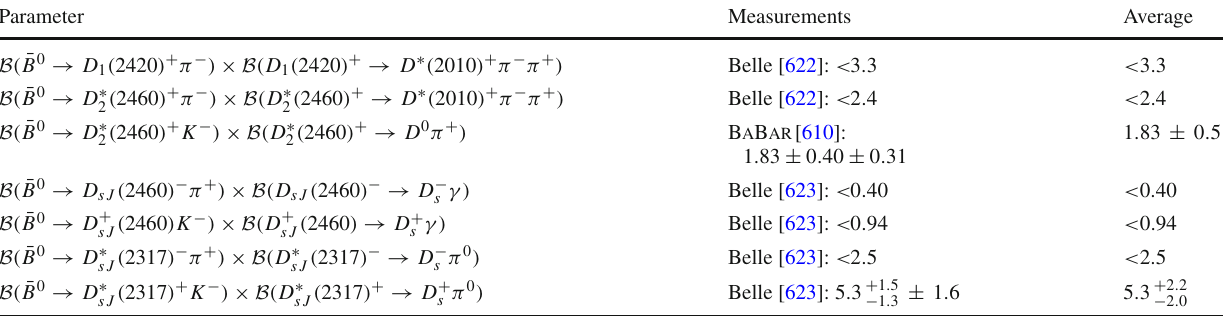
Table 102 Absolute product decay rates to excited D mesons II [ 10 − 5 ]